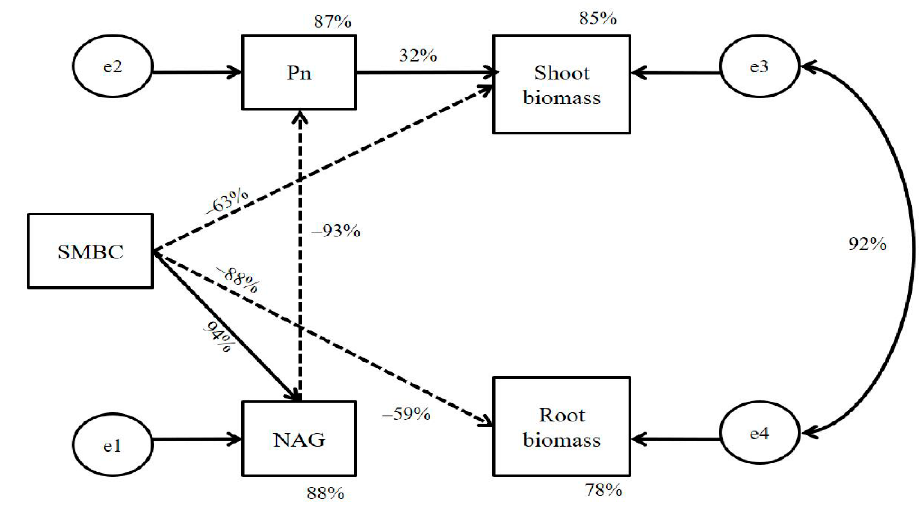
Figure 4. Results of the structural equation models of the effects of SMBC and soil NAG activity on plant Pn and biomass in the unsterilized soils. The model fit the data well: Chi-square = 2.610, df = 4, p = 0.625, NC = 0.652, RMSEA < 0.001, GFI = 0.941. The numbers on the arrows are the standardized path coefficients (equivalent to correlation coefficients). Circles indicate the error terms (e1–e4). Percentages close to endogenous variables indicate the percentage of the variance explained by that variable in the model. Solid and dashed lines represent positive and negative effects, respectively.